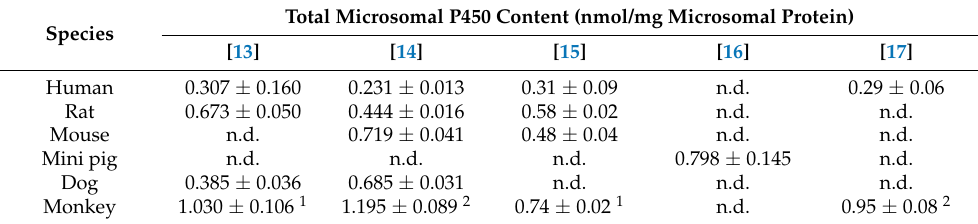
Table 5. Total microsomal P450 content reported for various